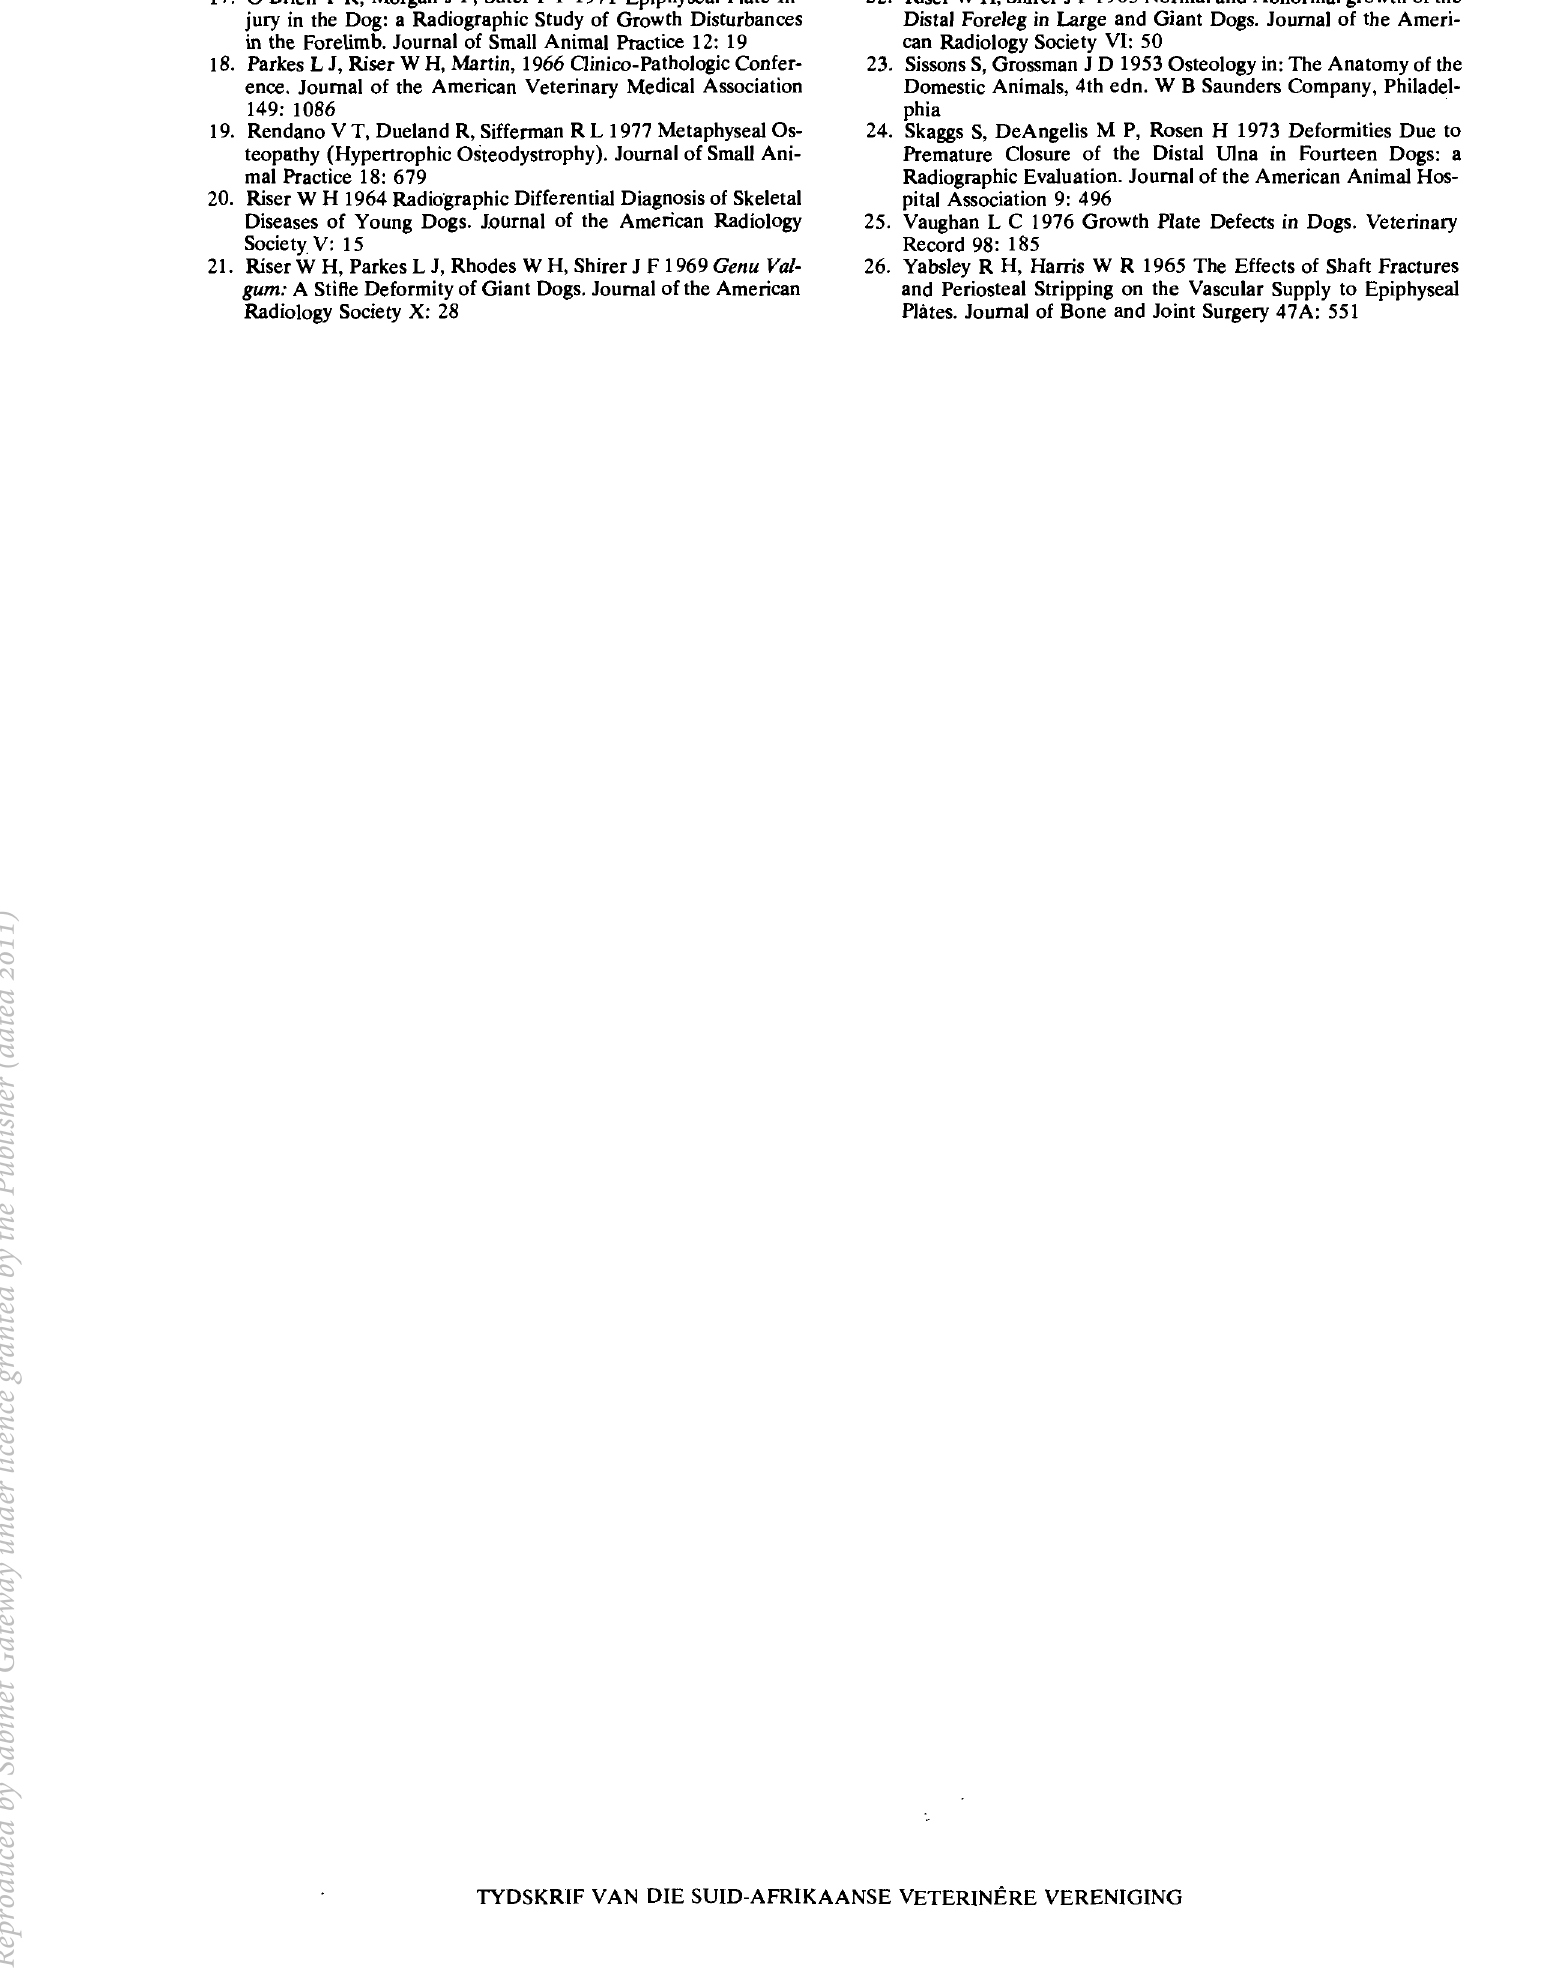
TYDSKRIF VAN DIE SUID-AFRIKAANSE VETERINERE